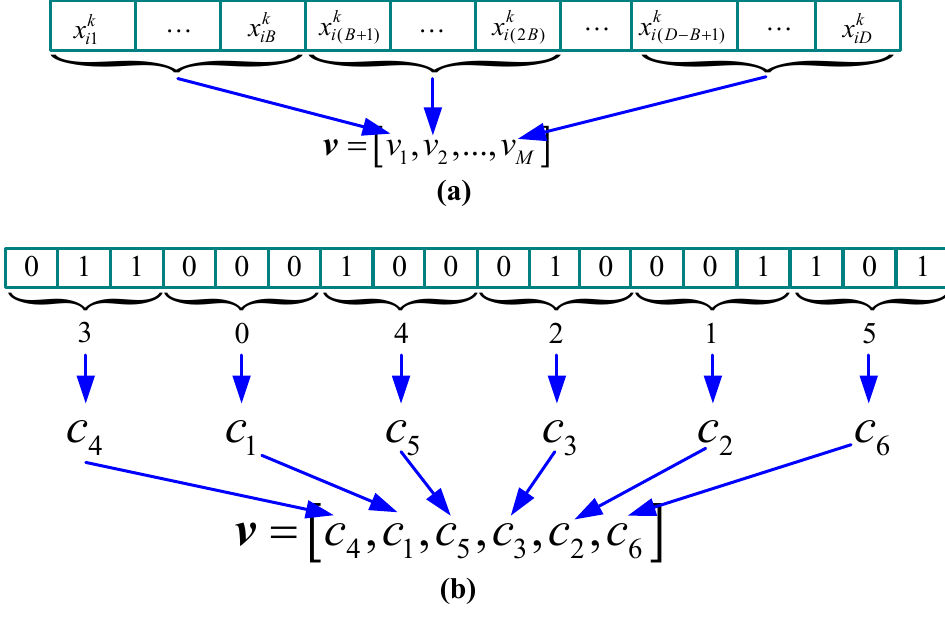
Figure 2. Mapping the position to the solution. ( a ) General representation. ( b ) An example where